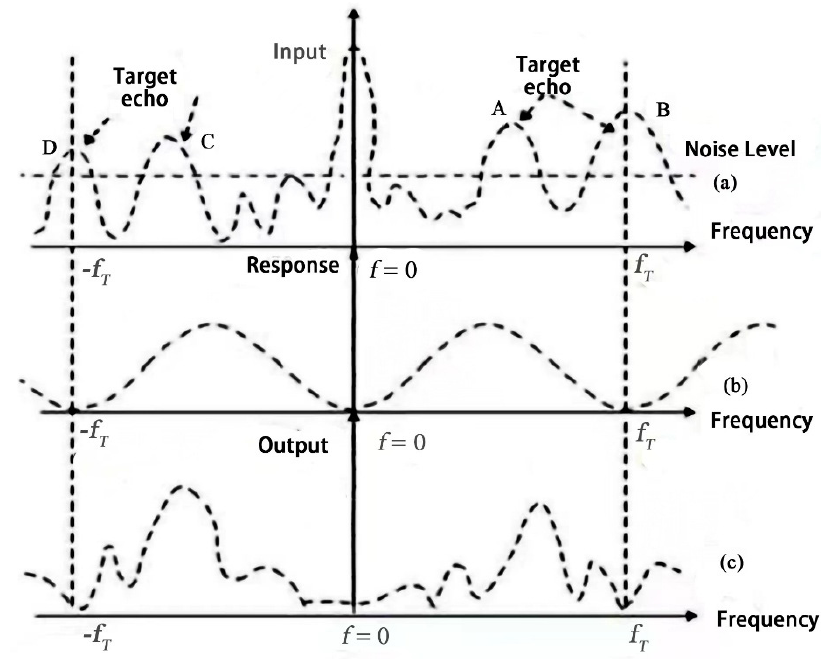
Figure 7. MTI spurious filtering.